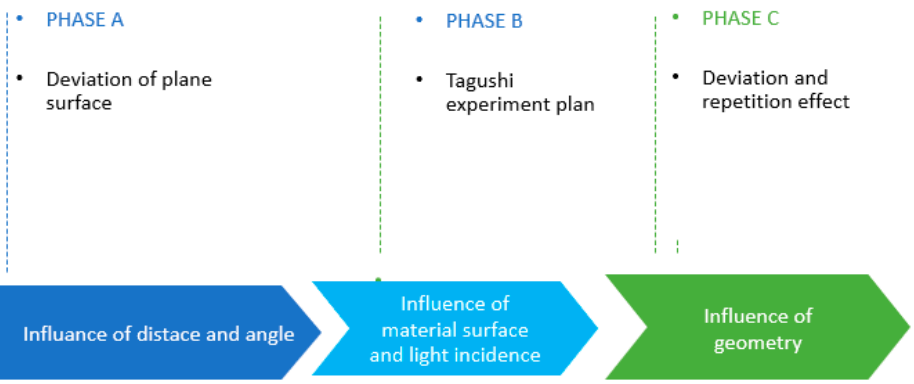
Figure 3. Laboratory Experimental Measurement Protocol.